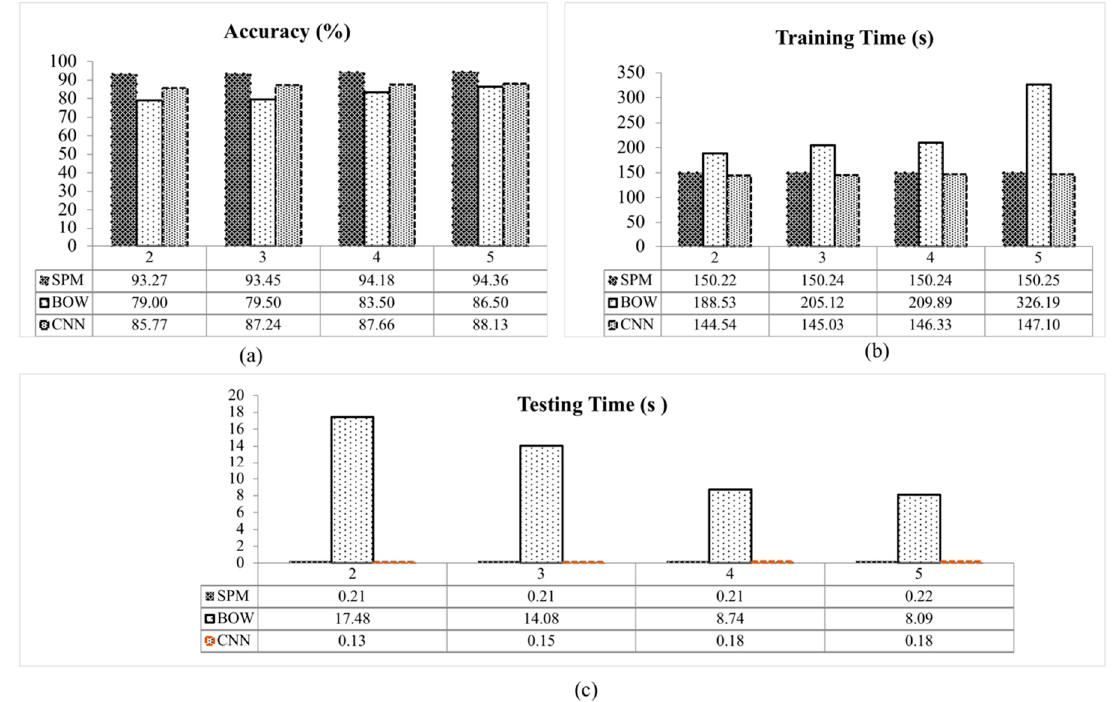
Figure 7. Evaluation on the effect of number of folds on: ( a ) classification accuracy, ( b ) training time and ( c ) testing time for each method with SVM classifier.